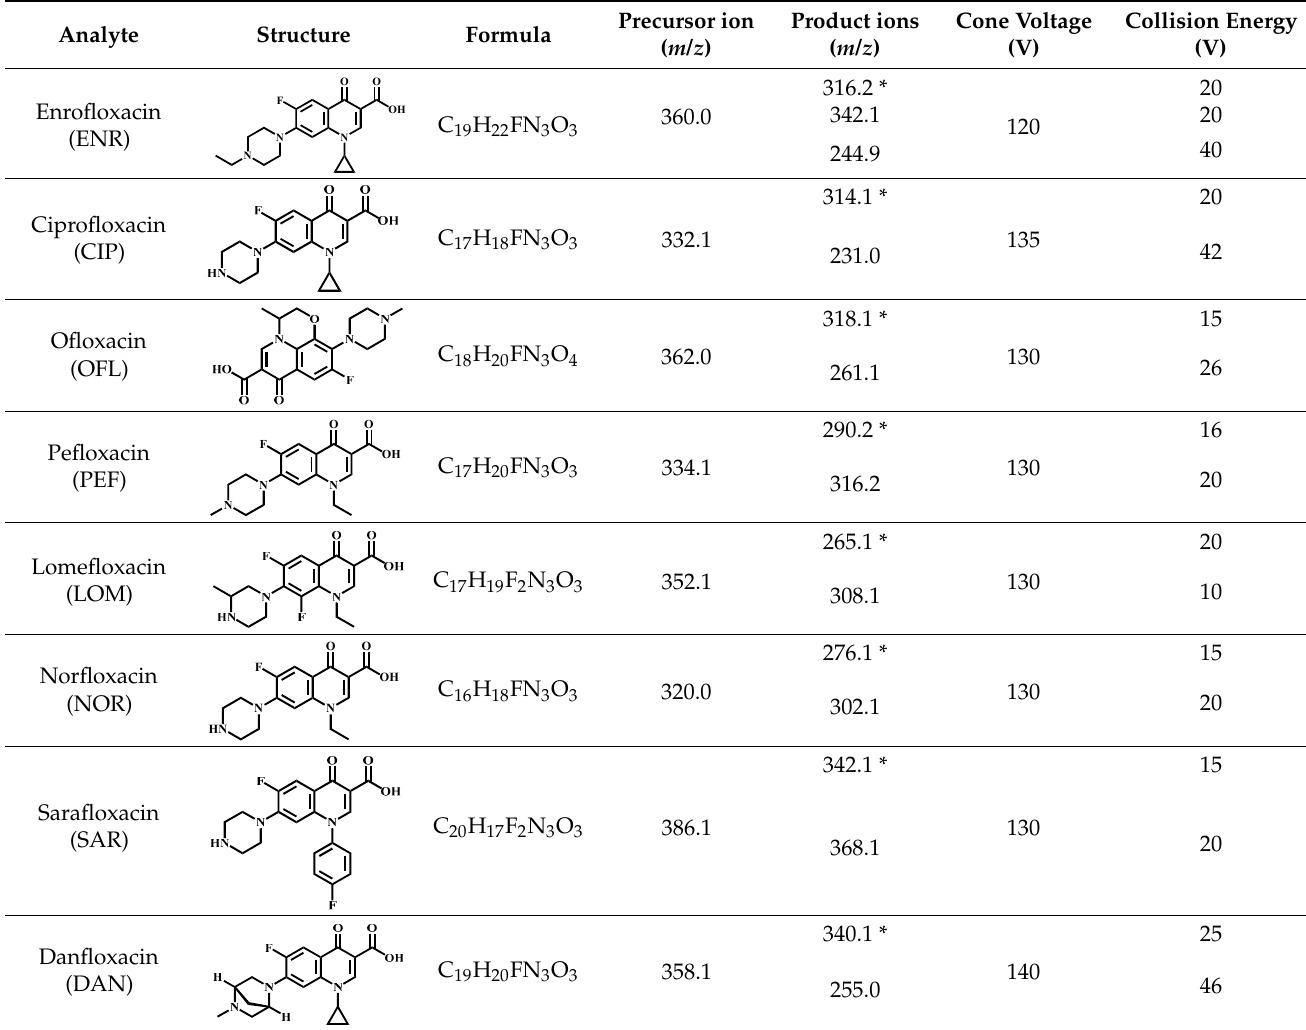
Table 1. Compound-dependent MS parameters for each analyte.